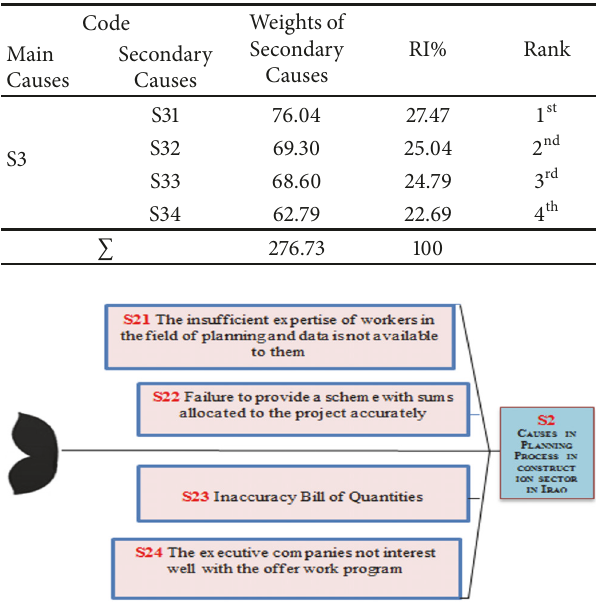
Table 4: Main causes weights, relative importance, and rank for project initiation management process group.